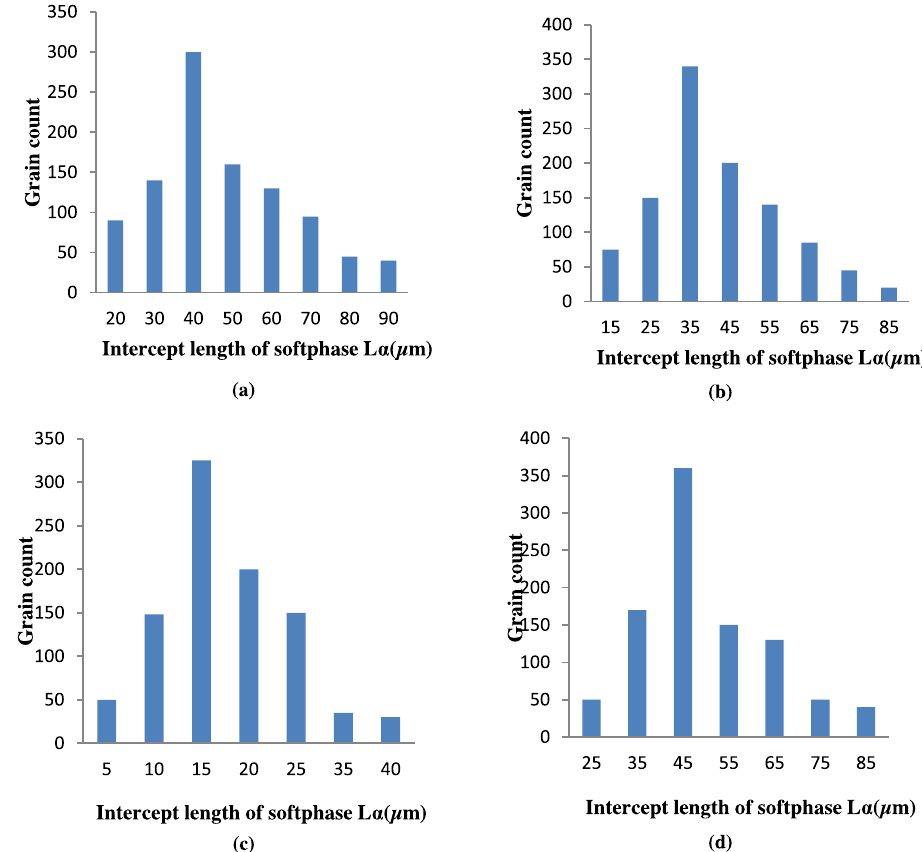
Fig. 7. Grain count numbers v/s intercepts lengths of soft phase L a (Tin) for (a) 650 rpm (b) 850rpm (c) 1050rpm and (d) 1250 rpm.